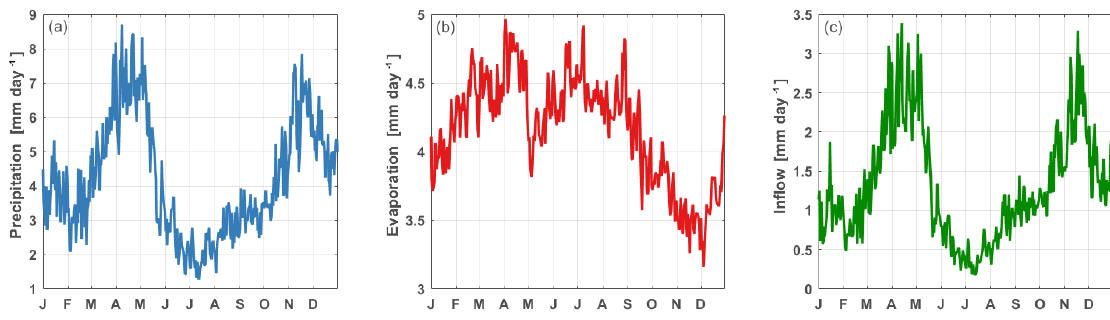
Figure 5. Climatology from 1993 to 2014: annual cycle of precipitation derived from PERSIANN-CDR observations (a) , evaporation from COSMO-CLM 2 model output (b) and inflow calculated with the CN method based on PERSIANN-CDR precipitation observations (c)